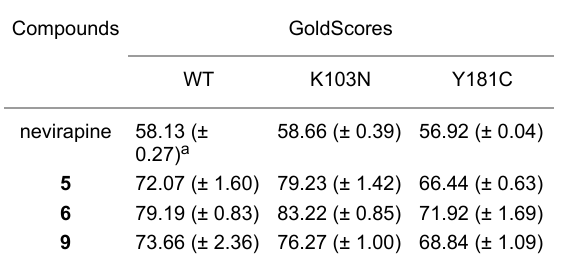
Table 2: GoldScores of nevirapine, 5 , 6 and 9 in wild-type (WT), K103N and Y181C HIV-1 RT.